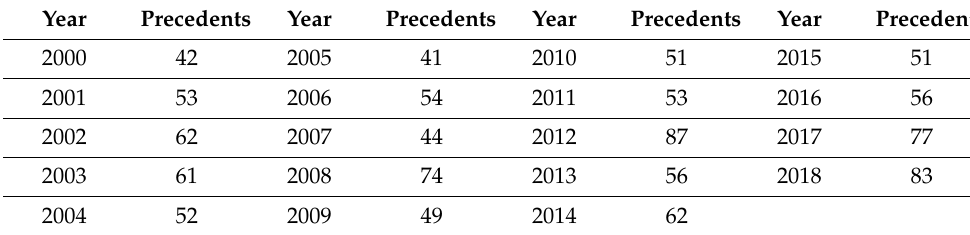
Table 1. The Numbers of Precedents of Each